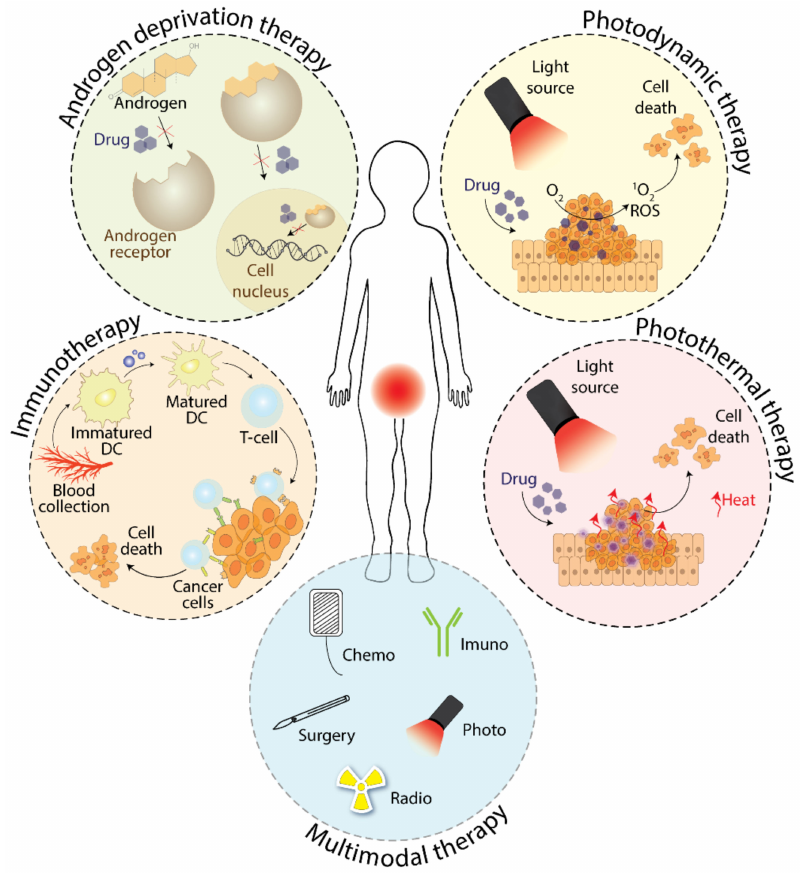
Figure 3. A scheme of various approaches for advanced prostate cancer treatment. DC—dendritic cells. The LHRH antagonists act by rapid inhibition of LHRH without any initial stimulation of the LHRH receptor. The physiological response is immediate and there is a rapid decrease in serum levels of LH, FSH, and testosterone without any initial increase. This is in contrast to the use of LHRH agonists. LHRH antagonists are designed to avoid the stimulation phase of the LHRH receptor [30,31]. An example of an LHRH antagonist is degarelix (Firmagon ® ; Figure 4) approved by the European Medicines Agency (EMA). Degarelix is a selective antagonist of gonadoliberin used to treat adult men with advanced hormone-dependent prostate carcinoma. It competitively and reversibly binds to receptors releasing gonadotropins in the pituitary gland in the brain, thereby rapidly reducing the release of gonadotropins, LH, and FSH, which leads to the reduction of testosterone secretion in the testes [32–35]. Although LHRH therapy might seem to be effective, it presents one major disadvantage, and this is long-term side toxicity since low testosterone serum levels corresponding to that after castration results in bone demineralization and an increased risk of myocardial infarction and